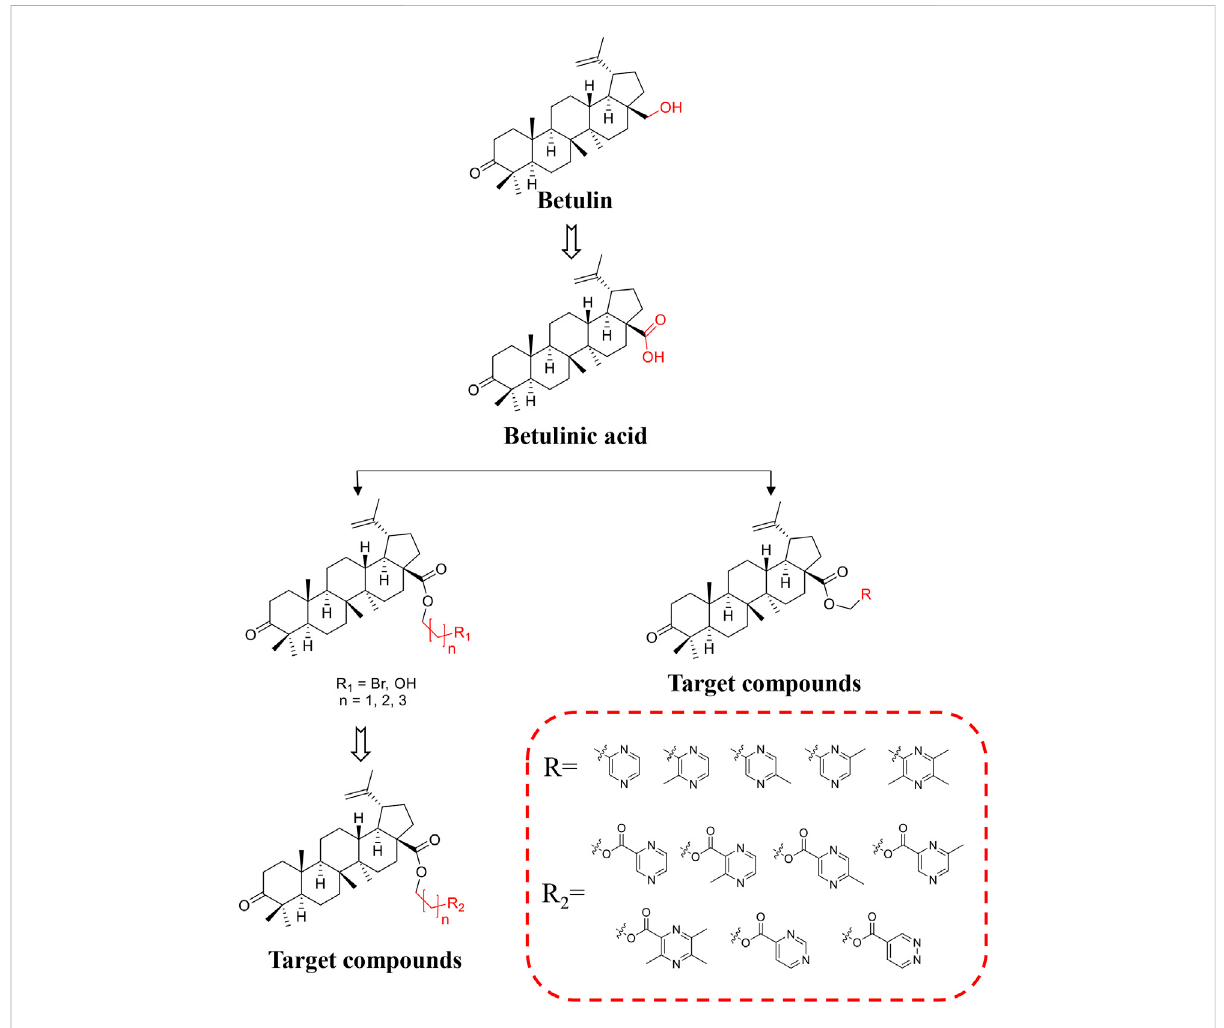
FIGURE 2 Illustration of the design strategy for target